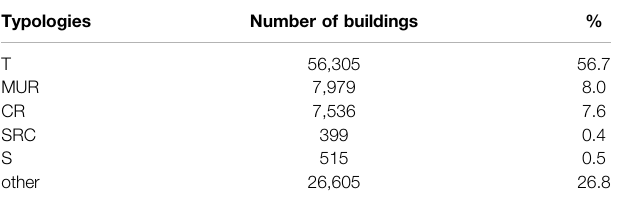
TABLE 3 | Distribution in terms of numbers and percentages of the predicted building typologies. Typologies Number of buildings